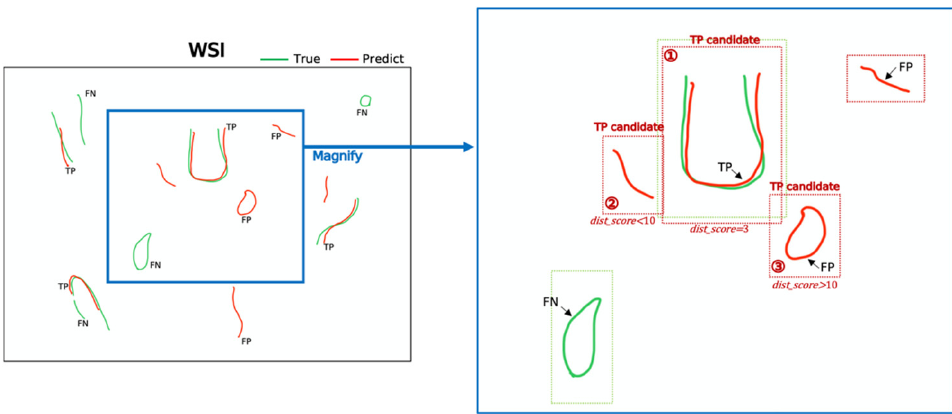
Figure 7. A conceptual illustration of how the matching information is calculated. The F1-score is the harmonic mean of precision and recall. Precision is the number of true positives divided by the number of predicted positives, and recall is the number of true positives divided by the number of real positives. precision × F1-score = 2 ×